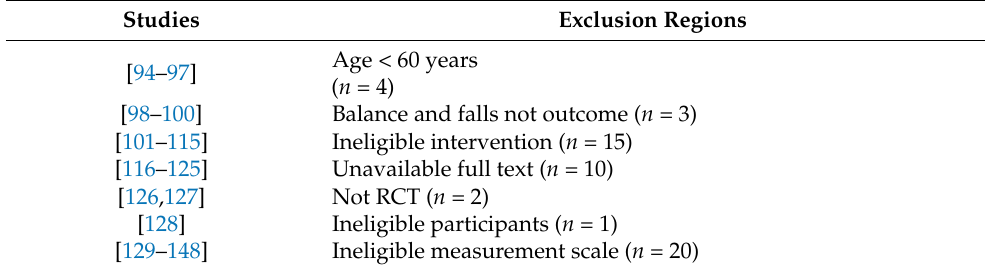
Table A2. Reasons for excluded study after full-text reading.